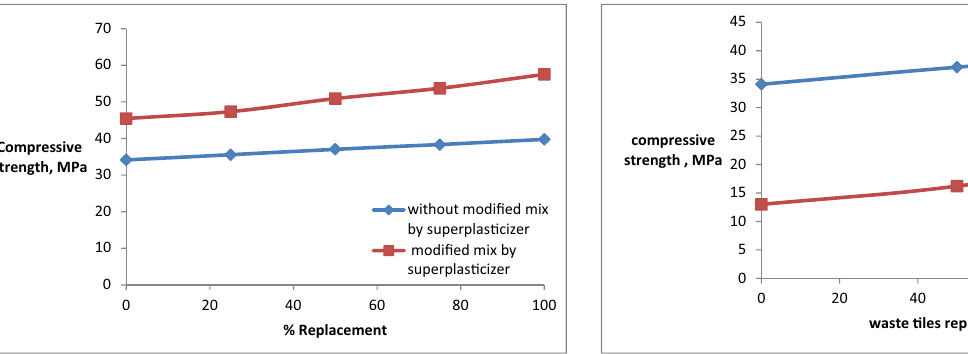
Figure 10: Compares on the relationship between compressive strength and replacement with and without modi fi cation by super -